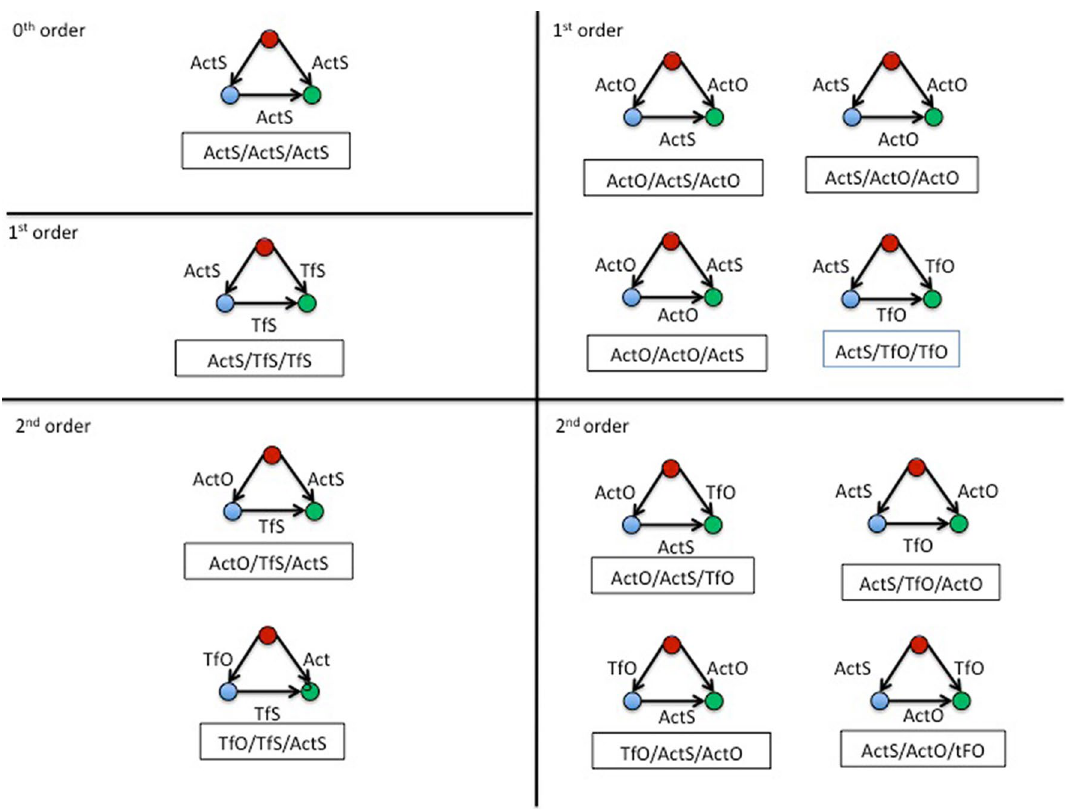
Figure 9. Significant Flux subgraphs of different order. Top left: The Flux subgraph in the ActS layer appear different from random (Flux ActS = I: 1654.2 ± 190.6; p value: 6 × 10 −4 but the coherence does not reach a clear significance (0.03), indicating a low stability; Top right, middle left: Flux subgraphs within ActS and ActO interacting layers appear quite robust, as well as ActS and TfO. ActS and TfS Flux shows a significant I but not C. Bottom left and right: As for the 2 th order subgraph in the α-hierarchical level, most of the flux combinations show a significant intensity (I). However, only two reach significance for Coherence (C): Flux ActO/TfS/ActS and Flux TfO/TfS/ActS. See the text for further